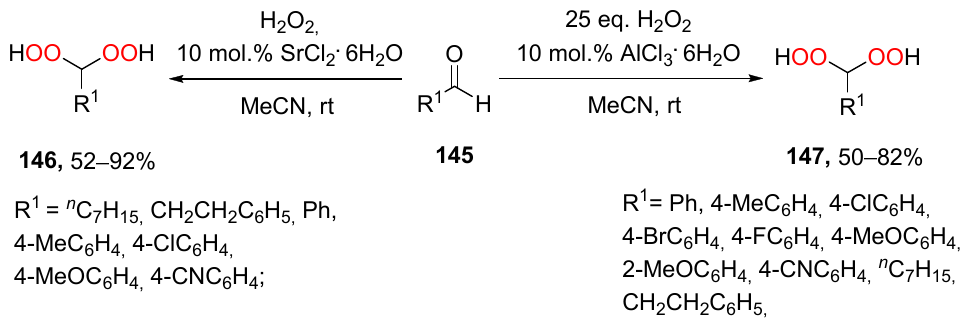
Scheme 50. Synthesis of geminal bishydroperoxides 146 and 147 from aldehydes 145 . Lewis acids such as SrCl 3 · 6H 2 O [142], cerium ammonium nitrate (CAN) [143], Bi(OTf) 3 [144], and AlCl 3 ·6H 2 O [114] are effective catalysts for the synthesis of bishydrop- eroxides 149 – 152 from cyclic and acyclic ketones and aldehydes 148 . Peroxidation pro- ceeds under mild conditions at room temperature with the formation of target peroxides in a good yield. All Lewis acids demonstrated approximately equal efficiency in the pe- roxidation reaction. The main advantage of these methods is the use of Lewis acids in catalytic amounts and an inexpensive 30% aqueous H 2 O 2 (Scheme 51).